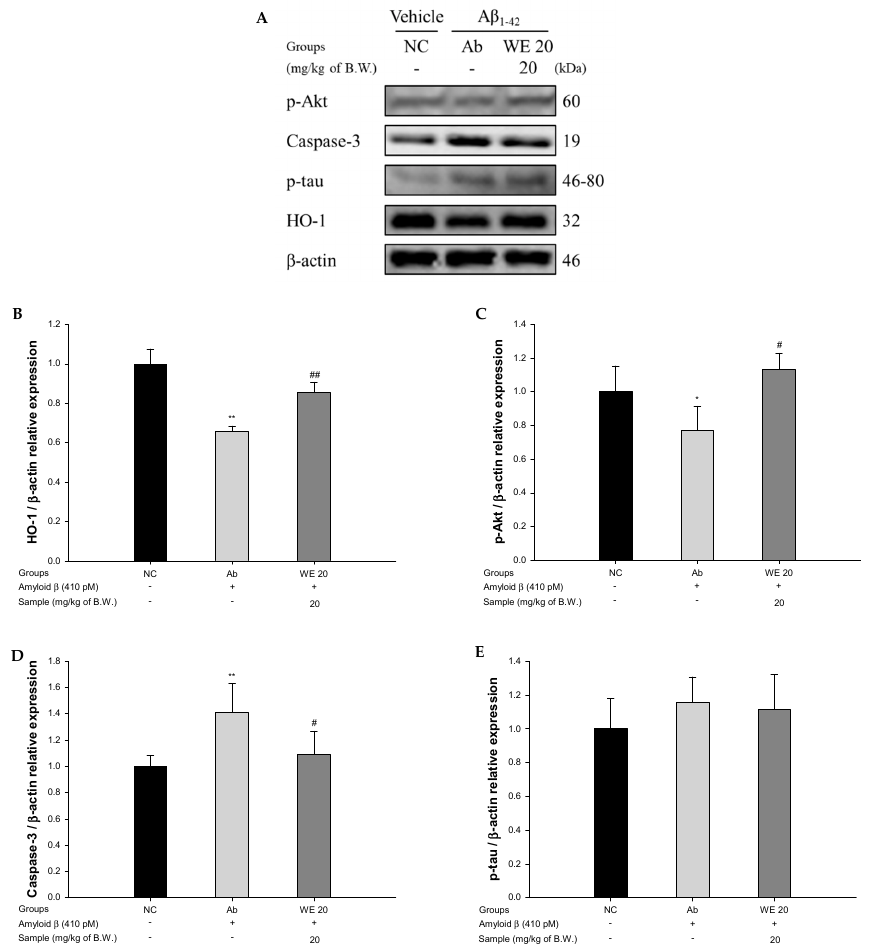
Figure 9. Protective effect of walnut ( Juglans regia L.) extract on A β -induced, A β -related, protein kinase B (Akt) protein expression change: ( A ) protein expression levels; ( B ) representative Western blots for total protein and expression of phosphorylated Akt (p-Akt) ( B ), caspase-3 ( C ), hyperphosphorylated tau (p-tau), ( D ) and heme oxygenase-1 (HO-1) ( E ) in mice brain tissues. Results shown are means ± SD ( n = 3). Data are statistically represented at * = significantly different from the NC group; # = significantly different from Ab group, respectively; * and # p < 0.05, ** and ## p < 0.01.